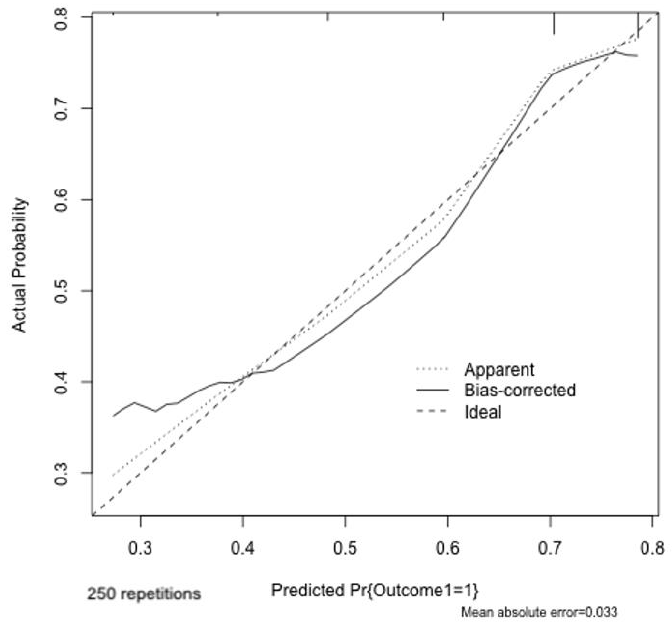
Figure 4. Calibration plot. Smoothed (loess) calibration plots reporting increasing predicted proba- bility of adverse events by the assessed model. The diagonal line indicates the ideal line of perfect correspondence of predicted to observed adverse event rate. Mean absolute error rate was 3.3%.